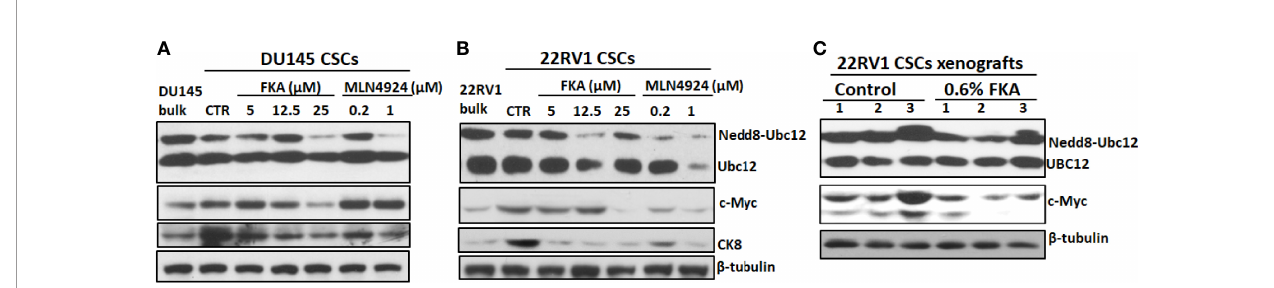
FIGURE 6 | Inhibition of neddylation by FKA and MLN4924 downregulates the expression of c-Myc and CK8. (A, B) Representative pictures of the Western blotting analysis of Ubc12 neddylation and expression of c-Myc and CK8 in DU145 and 22Rv1 CSC prostaspheres at G2 after indicated concentrations of control, FKA and MLN4924 treatments for 48 h. (C) Western blotting analysis of Ubc12 neddylation and c-Myc expression in 22RV1 xenograft tumors from mice fed with control and FKA formulated diet for 18 days. Experiments were repeated thrice, and b -tubulin was used as a